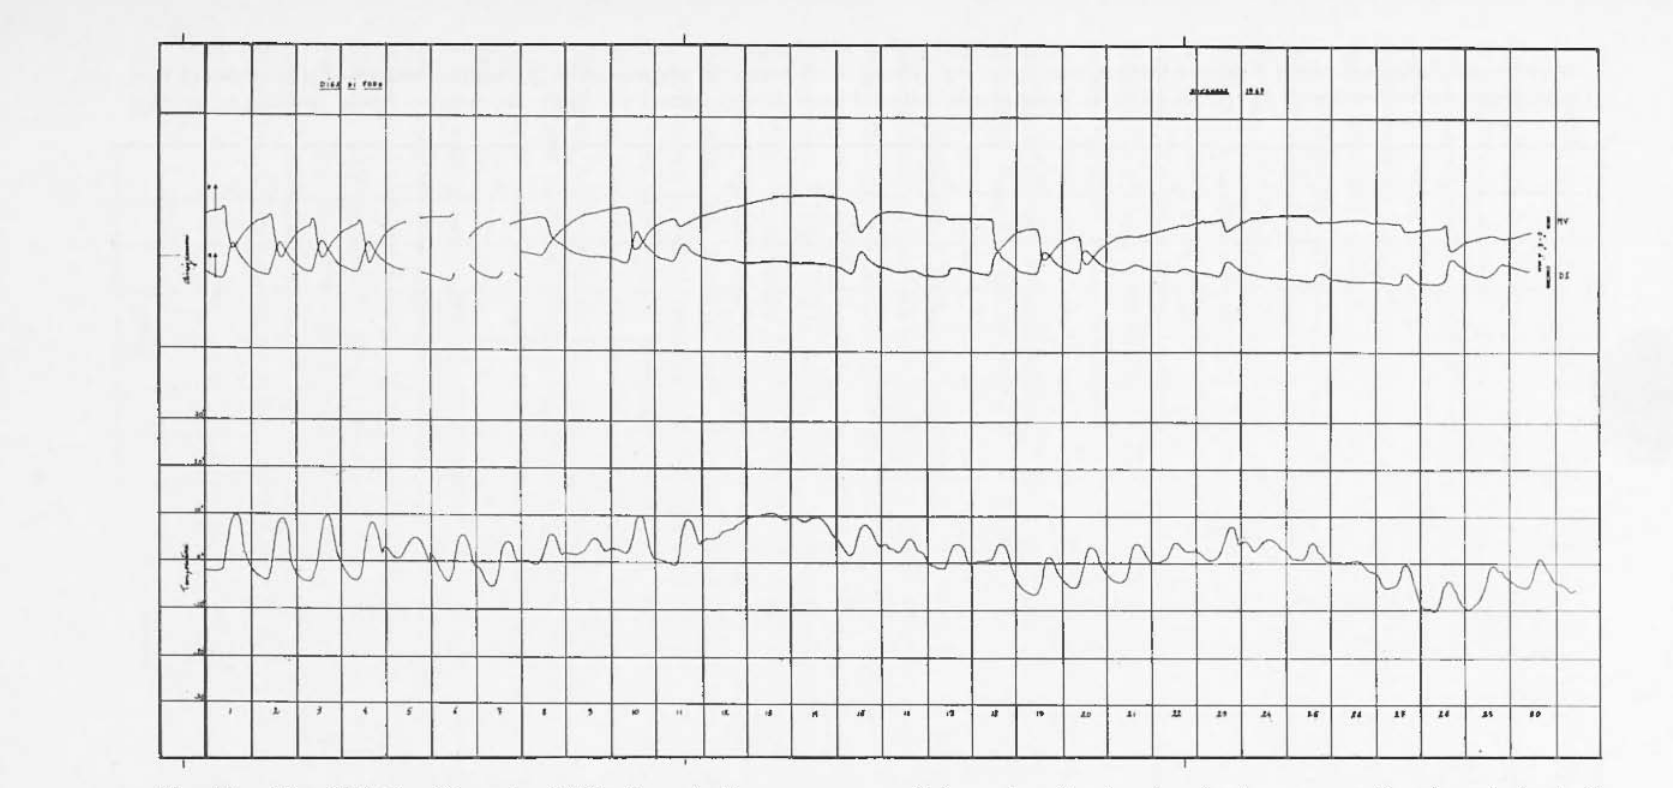
:Fig. 13 - Diga di Vodo );ovemhre HH5!! . Le ollde dilll"llC SOIlO prel\Cllti ill mOllo lleUo, in cntnulll)(' le ('OllljlO1Wnli, Kolo Ilei giorni di maggio!" eKClll"~i()IlO termica. L'osdllaziollc diurna dE'ila. componente ~illi~tra'llestr:l, (!opo i primi giol'lli del Ul('.SC non }ln·.f;l'uta più il!Jie('() iniziale ,li rotazione a dI'stra. Le variazioni di indinll.lIione Il. hmgo periollo si jJl"(·SI'lltn.J1O Ìll UlOtlO lIBUauwlltl' anomalo 1I1'1la compo· nente lHollle-valle; ~i rilevallo ill[atti fleH~i()lli a valle a seguito di llll riHeaidallll'll10 e a III011te per ratIn'llllamento. ~('lla COmpOlll'nte ~ini,~tra.tleRtra si lHlnno variazioni ll'illclillHziolle a lungo pl'riotlo a IleHtra per